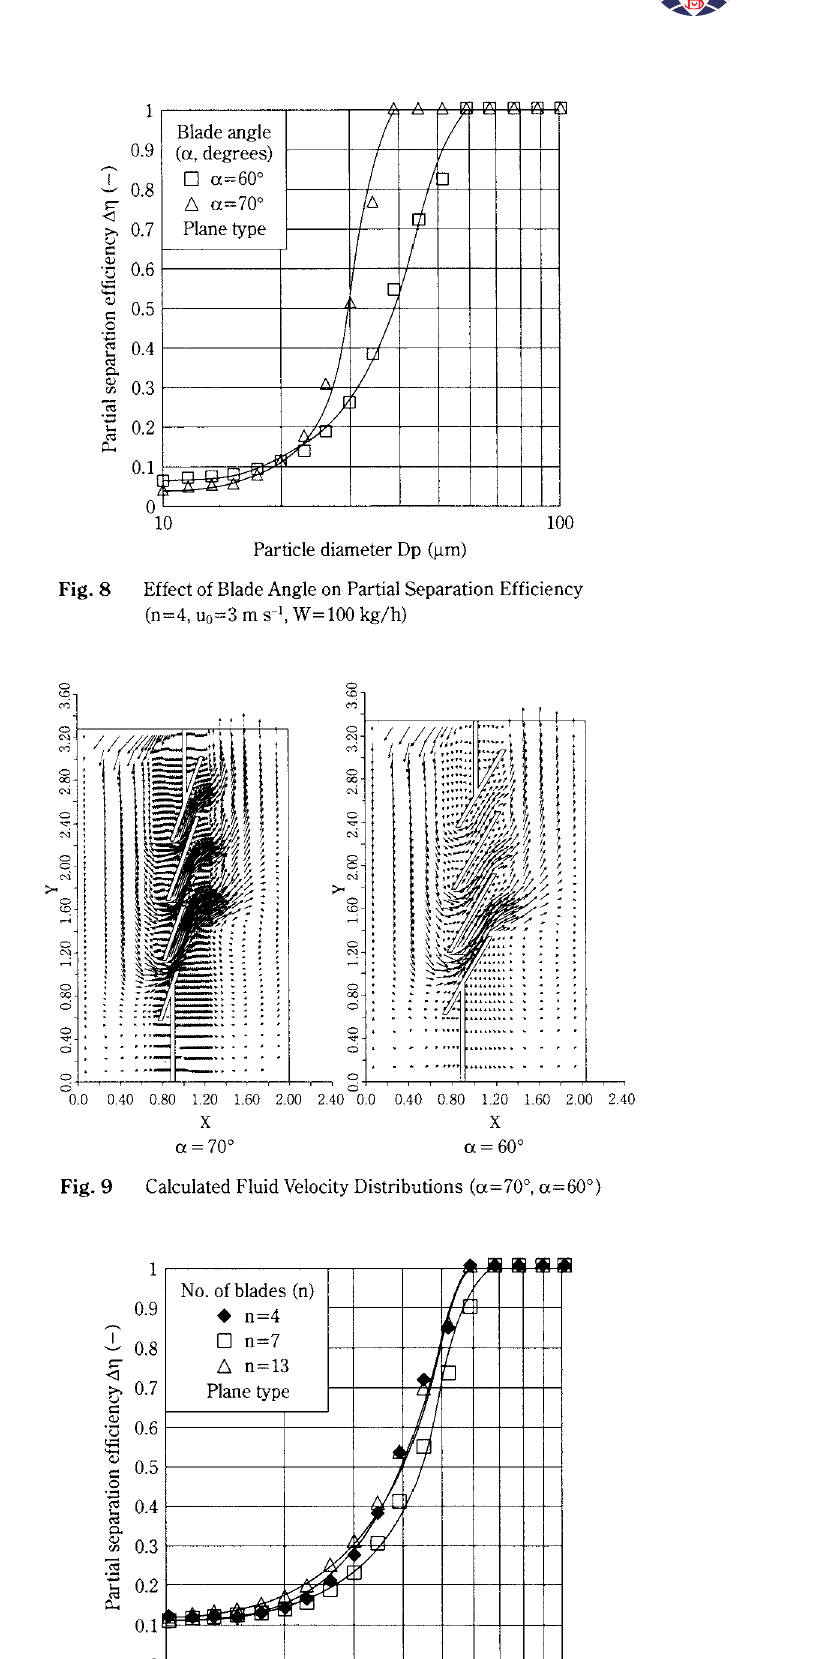
Fig. 10 Effect of Number of Blades on Partial Separation Efficiency